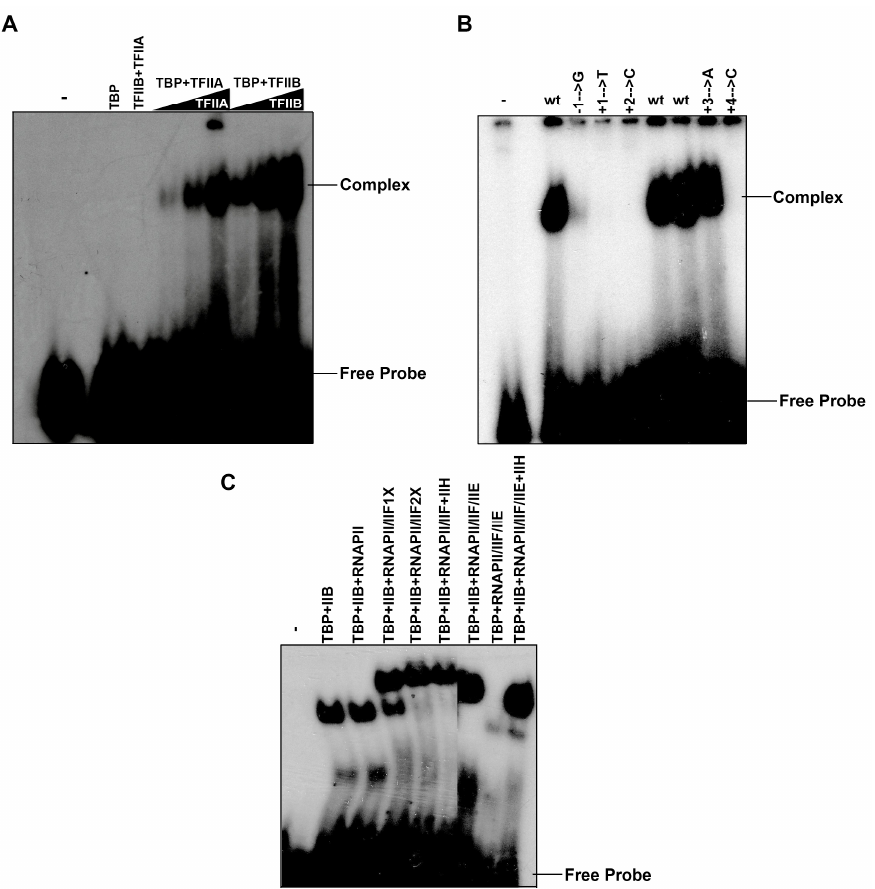
Figure 5. TBP binds to the nmt1 Inr in a complex, either with TFIIA or TFIIB. ( A ) TFIIA/TFIIB added together to a binding assay with a labeled probe containing the wild-type nmt1 Inr do not produce a detectable complex; however, when TFIIA or TFIIB are added together with TBP, complexes are obtained, indicating that TBP binds to the Inr in the presence of these factors. ( B ) Mutants of the nmt1 Inr, which are impaired in transcription, cannot form a TFIIB-TBP complex, indicating that these conserved positions are required for TFIIB-TBP complex formation. ( C ) Preinitiation complex formation on the nmt1 Inr follows a similar pathway as TATA box-containing promoters. It can be observed that TFIIB-TBP does not form a new complex with RNAPII in the absence of TFIIF; however, when RNAPII + TFIIF (RNAPIIIIF) are added, a new complex is formed that migrates slower than the TFIIB-TBP complex. Adding TFIIH to this complex does not produce any change in its mobility or amount; however, when TFIIE is added, the intensity of the complex augments, indicating that TFIIE was incorporated. A similar process occurs when TFIIH is added to the TFIIB-TBP-RNAPII-TFIIF- TFIIE complex. In the absence of TFIIB, RNAPII + TFIIF is not recruited into the complex, indicating that TFIIB makes a bridge between TBP and RNAPII + TFIIF. Figure 5C was constructed from two panels from the same Western blot.